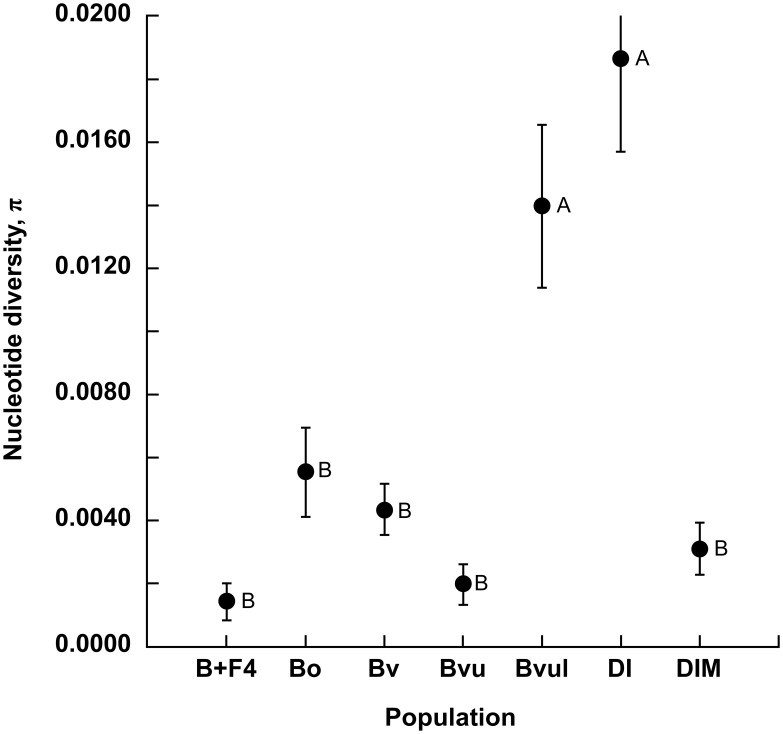
Nucleotide diversity of satBaMV populations.MEGA 5.2.1 [48] was used to estimate the nucleotide diversities and associated standard errors (vertical bars) of various satBaMV populations. Letters denote statistically different groups based on unplanned multiple comparisons with the Tukey-Kramer method [54]. For population designation, see Figure 1. B+F4 denotes the population from greenhouse-inoculated N. benthamiana.